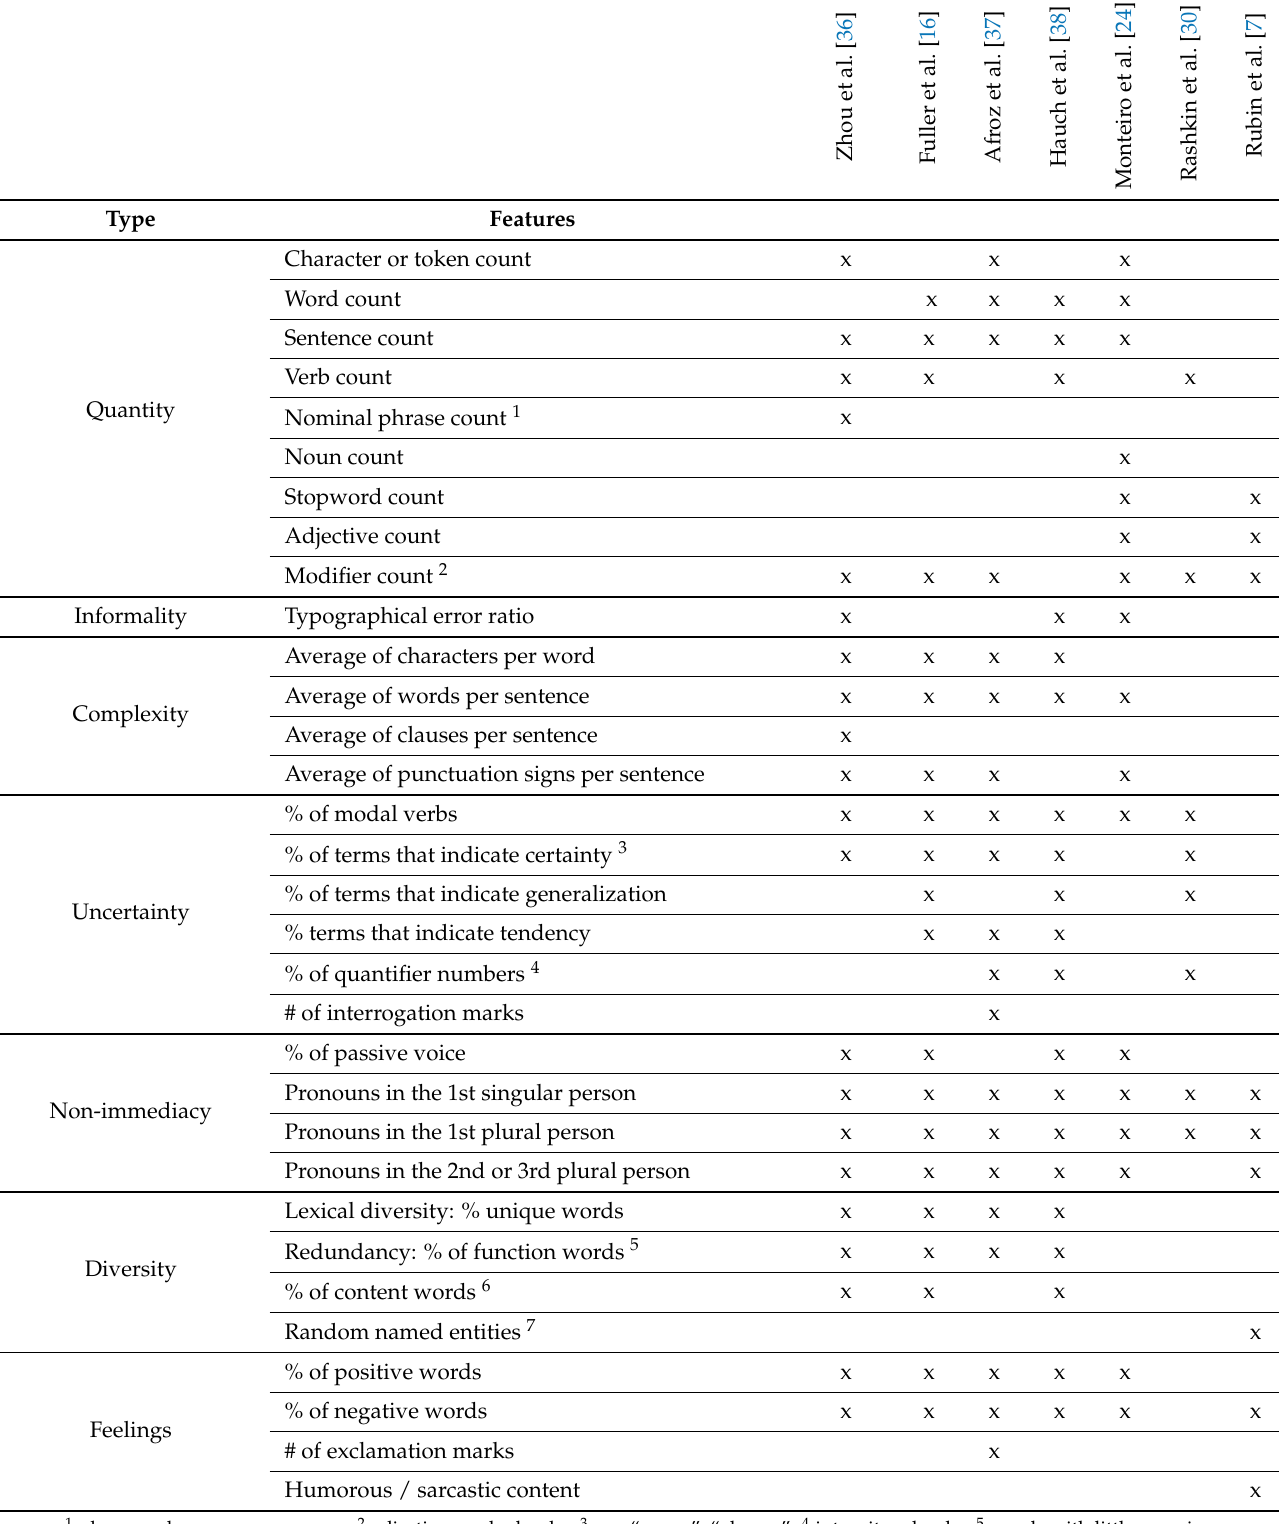
1 phrases whose cores are nouns. 2 adjectives and adverbs. 3 e.g. “never”, “always”. 4 intensity adverbs. 5 words with little meaning attached, used to express grammatical relationships between words or to specify the speaker’s attitude or mood, e.g., prepositions, pronouns, auxiliary verbs, conjunctions, and articles. 6 words that contain semantic content, e.g., nouns, verbs, adjectives, and most adverbs. 7 presence of proper names, never mentioned in the text